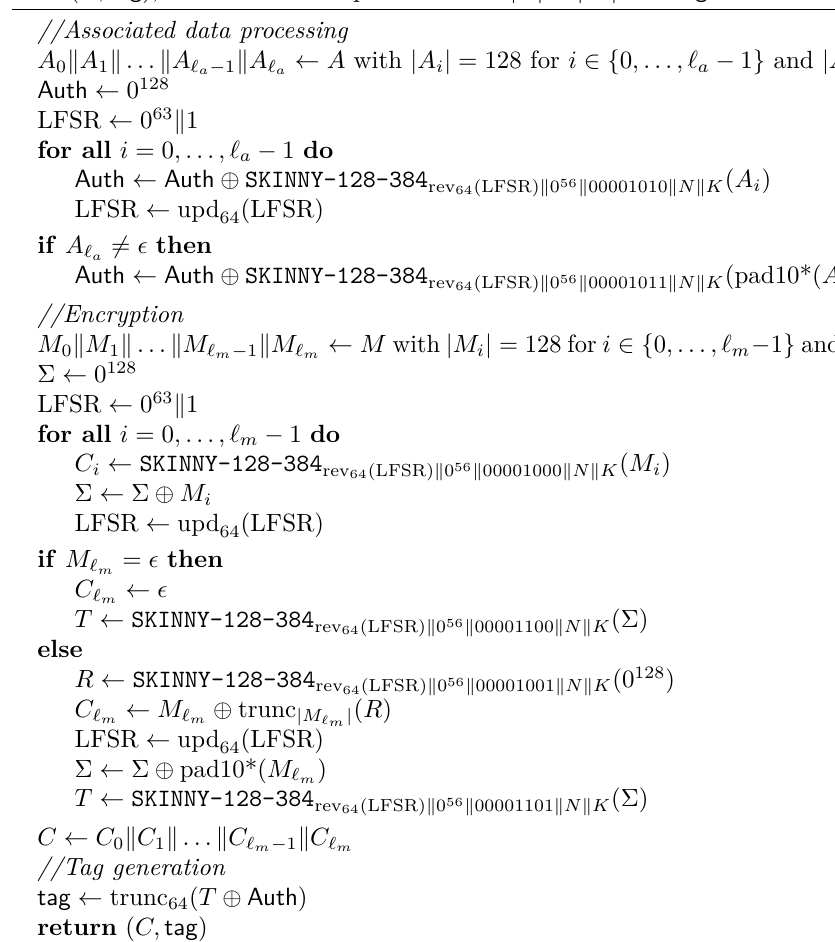
Algorithm 7 The authenticated encryption algorithm SKINNY - AEAD - M3 - Enc ( K, N, A, M ) In: Key K , nonce N (both 128 bit), associated data A , message M (both arbitrarily long) Out: ( C, tag ), where C is the ciphertext with | C | = | M | and tag is a 64-bit